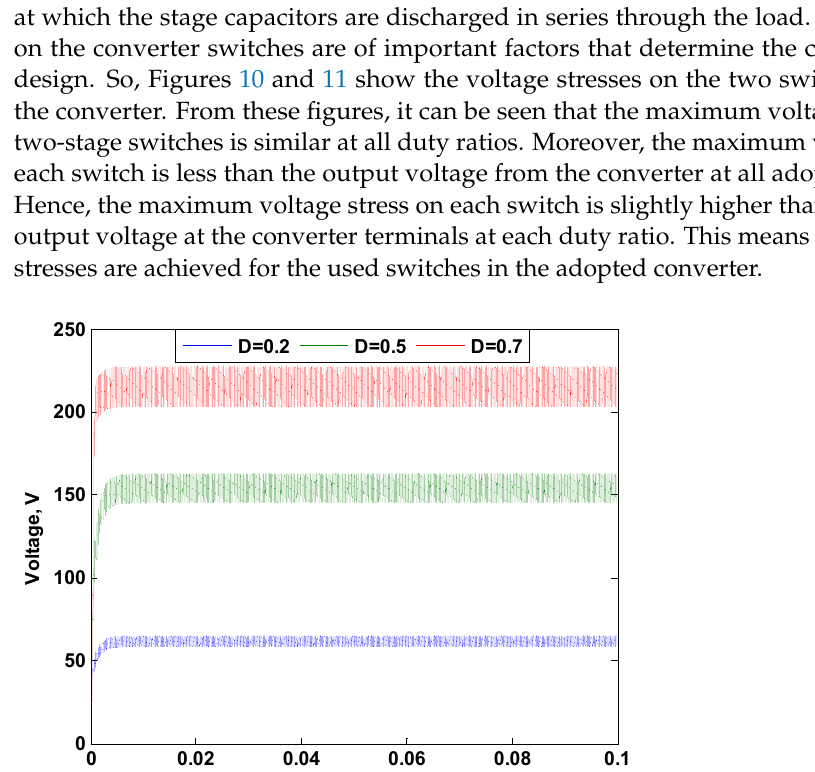
Figure 8. Voltage at the terminals of the first-stage capacitor at the same adopted duty ratios in Figure 7.